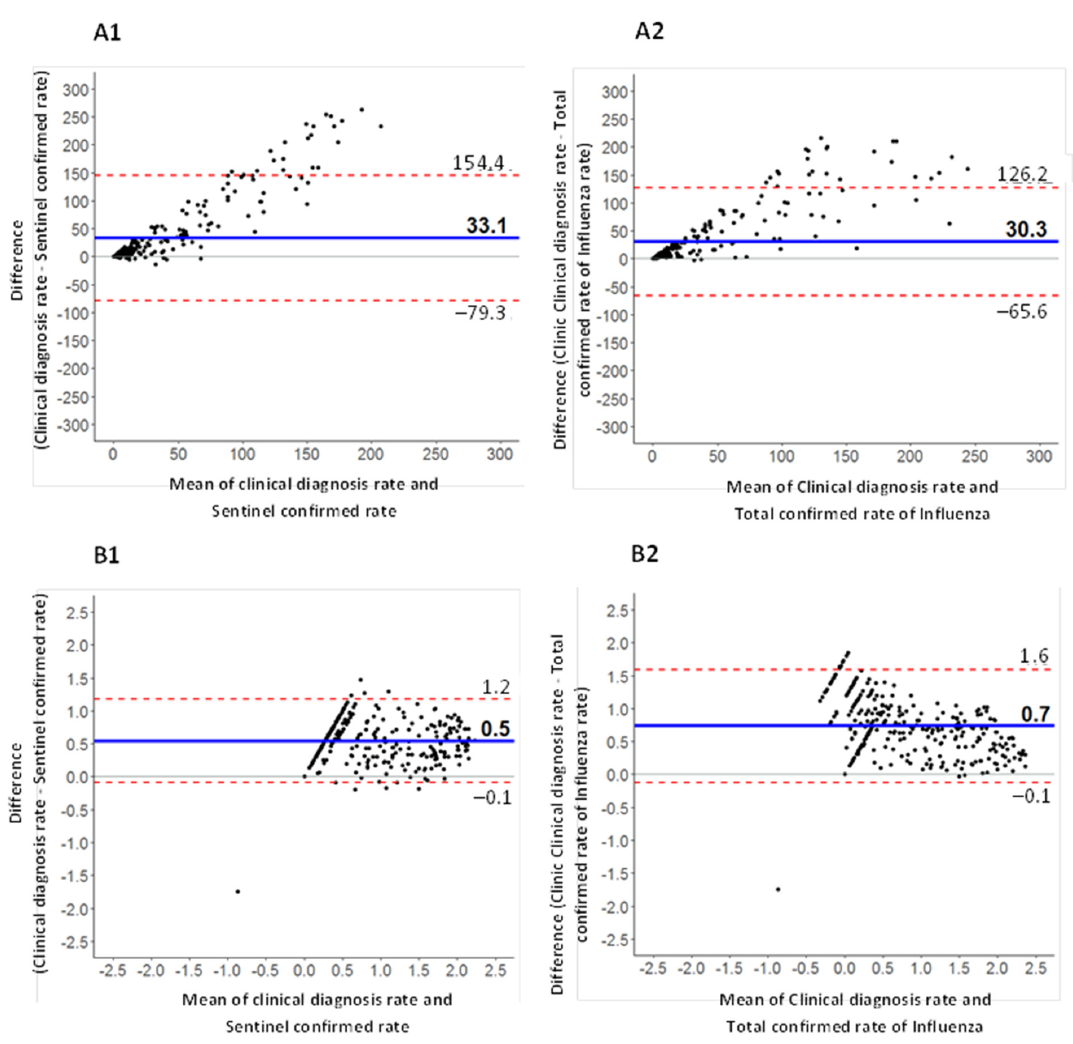
Figure 2. Bland-Altman graphs using data from all seasons studied. Figures ( B1 , B2 ) with logarithmic transformation. Figures ( A1 , A2 ) represent data before transformation. Figures ( B1 , B2 ) after applying logarithmic transformation. Table 2. Pearson and Spearman correlation coefficients between rates of clinical diagnosis, sentinel- confirmed, and total confirmed